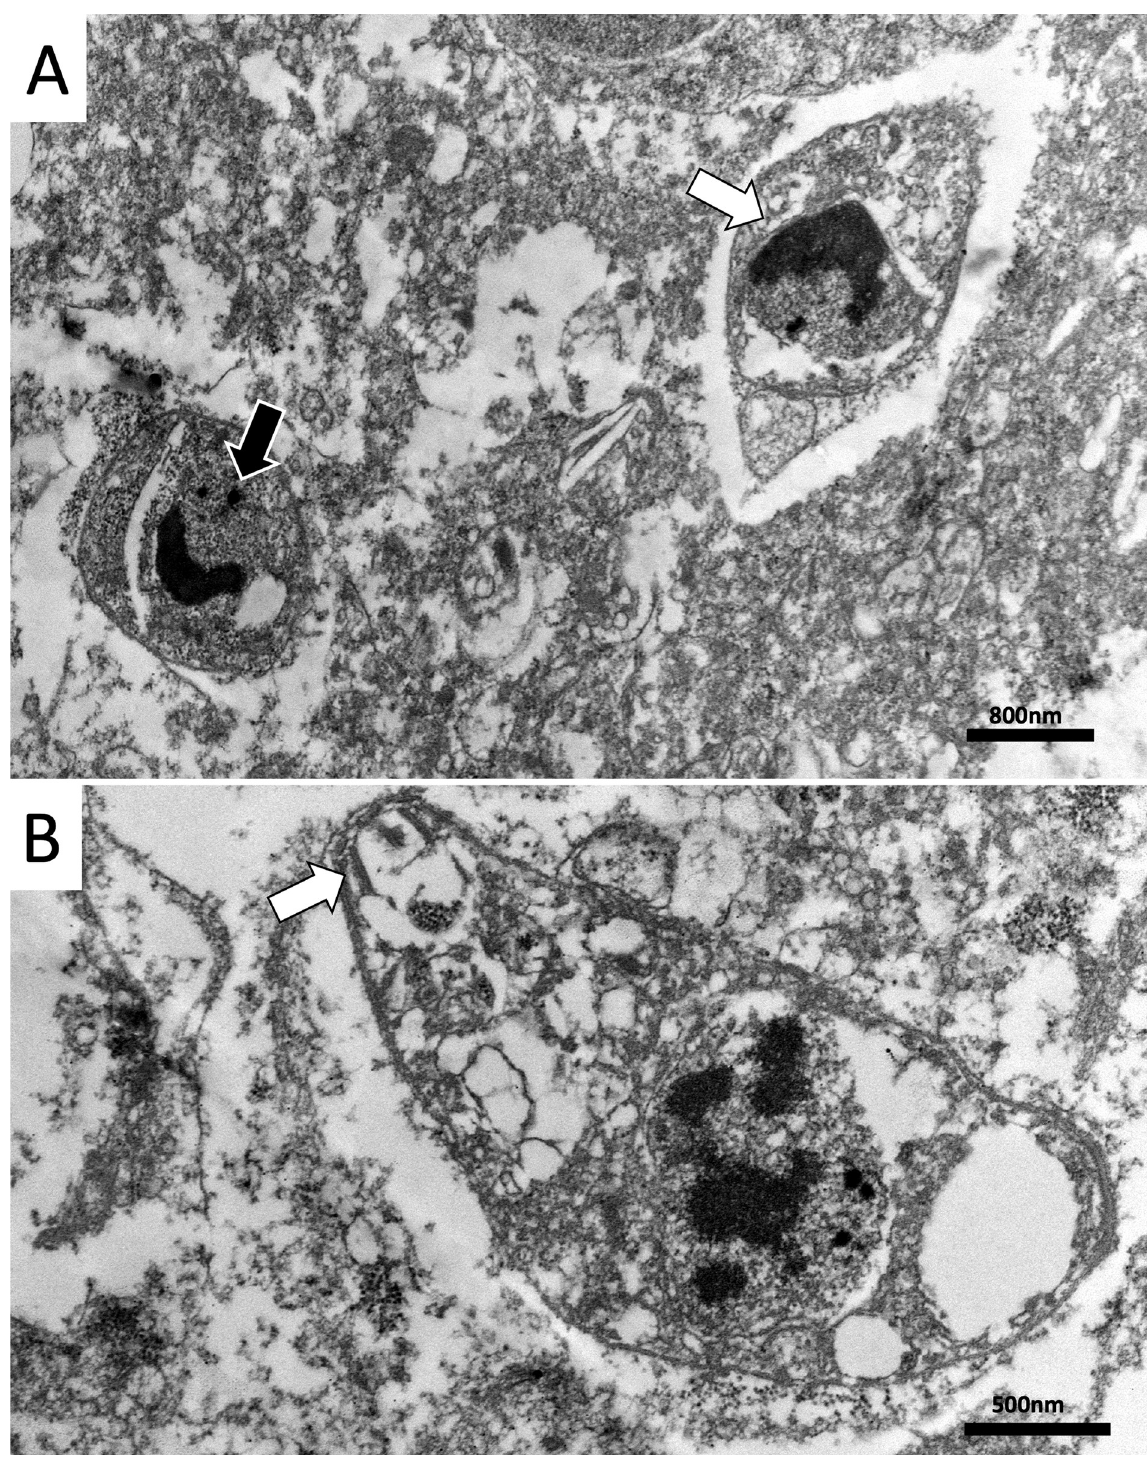
Fig 4. Transmission electron microscopy from the formalin-fixed paraffin-embedded tissue of an infected marmoset. Tachyzoites of Toxoplasma gondii , (A) Two ovoid organisms with 1.6 to 2.5 μ m x 1.3 to 1.4 μ m, a distinct nucleus (white arrow) and electron-dense granules (black arrow), Scale bar = 800 nm. (B) Tachyzoite with one central nucleus and a visible conoid (white arrow), Scale bar = 500 nm.